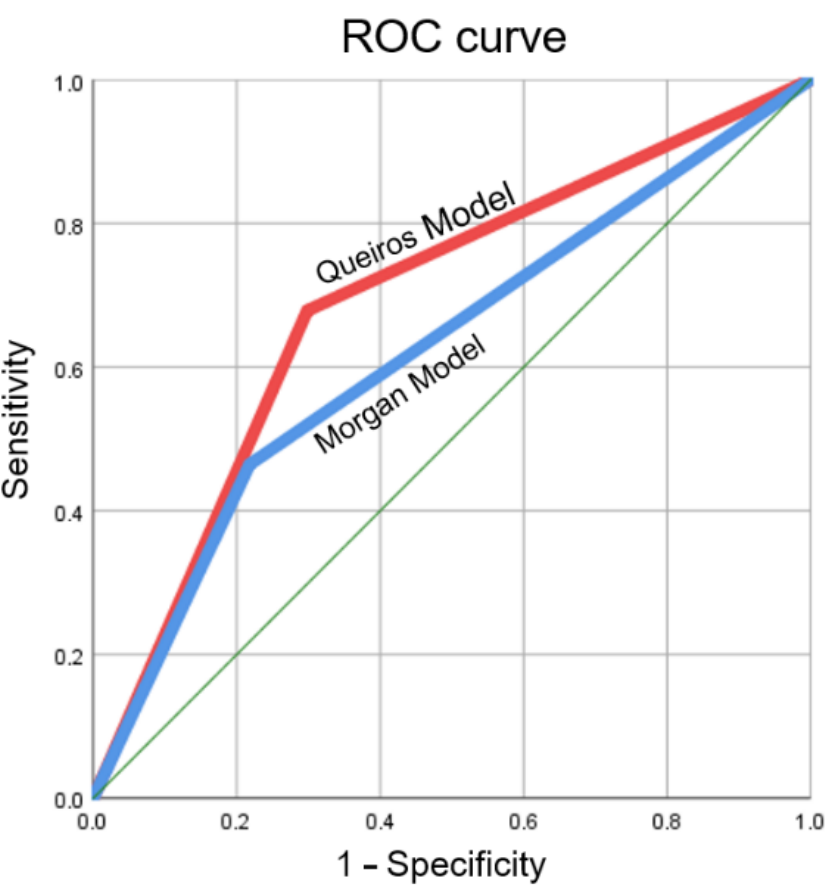
Figure 3. Receiver operating characteristic curves (ROC) for increment differences of 0.10 mm in axial length detected by Morgan’s equation (Morgan Model) and the present study (Queiros’s